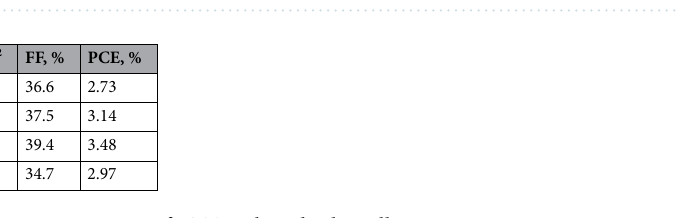
Table 5. Summary of optoelectronic parameters of CZTSSe based solar cells.